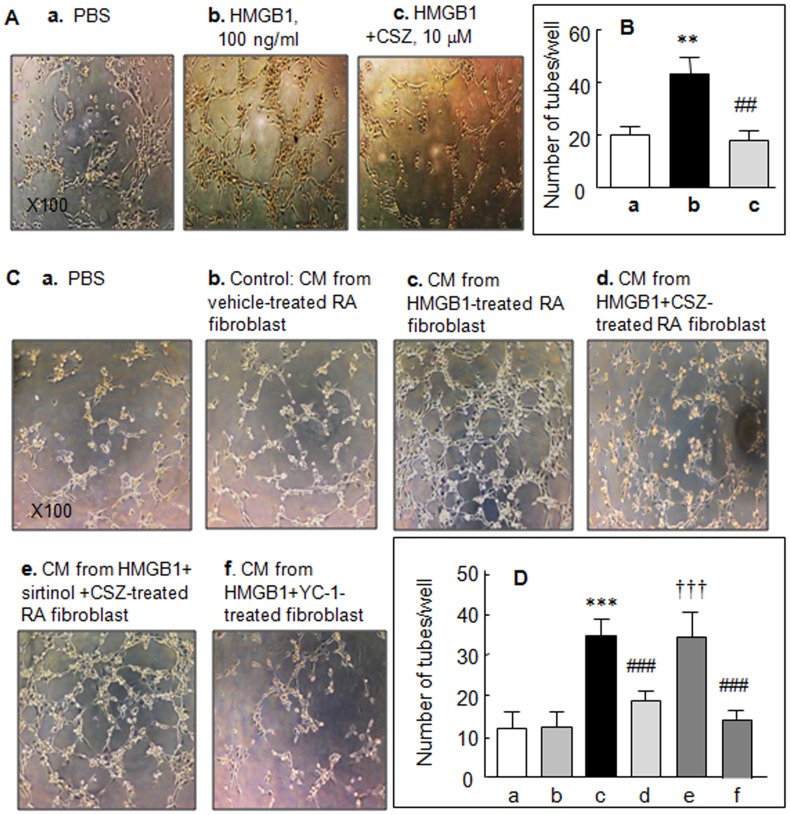
Suppression of endothelial cell tube formation by cilostazol (CSZ).Photographs of tube formation induced by HMGB1 (100 ng/ml), which was applied directly to the HMVECs in the absence and the presence of 10 µM of cilostazol (A) and by conditioned medium (CM) derived from cultures of HMGB1 (100 ng/ml for 48 hr)-treated RA synovial fibroblasts (C). Diluted CM was added to the culture medium after adding HMVECs to Matrigel. Cultures were photographed after 9 hr (×100). (B and D) Quantitative analyses: Results are mean numbers ±SEM of tubes per well for 4–5 experiments. **P<0.01, ***P<0.001 vs. PBS (phosphate-buffered saline); ##
P<0.01, ###
P<0.001 vs. HMGB1 alone; †††
P<0.001 vs. 10 µM cilostazol.